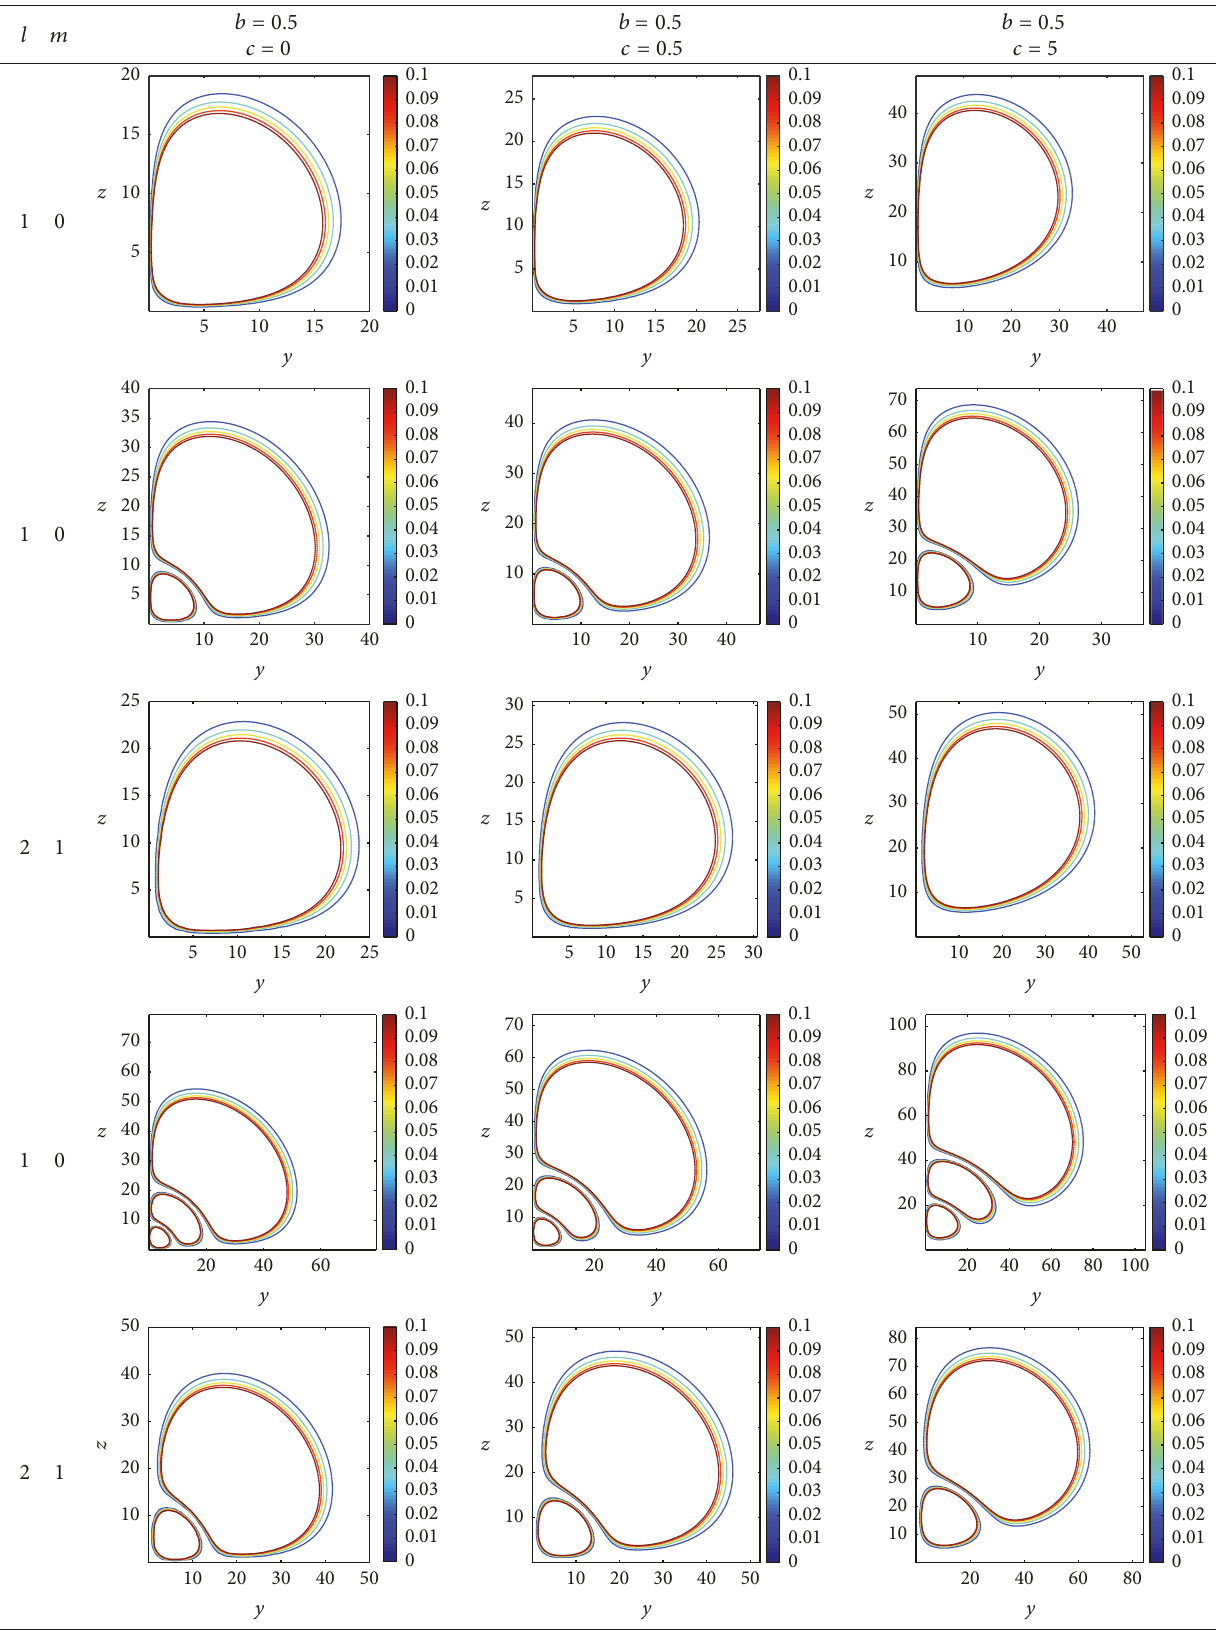
Table 2: The contour of the SPDs in the plane